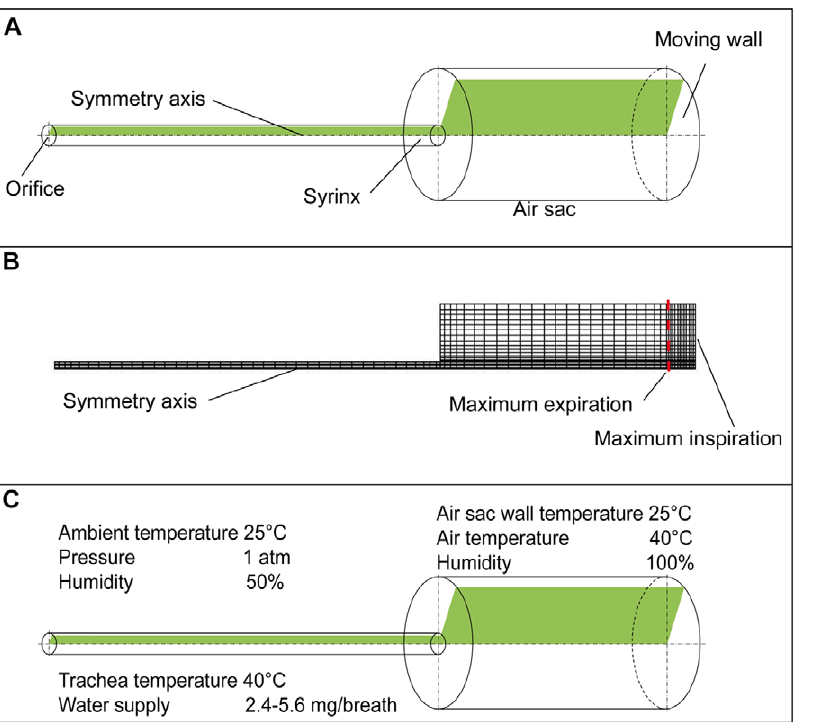
Figure 1. A simplification of the avian respiratory system for the domestic fowl. A) schematic representation; B) 2D finite element model; C) boundary conditions for the 2D model.